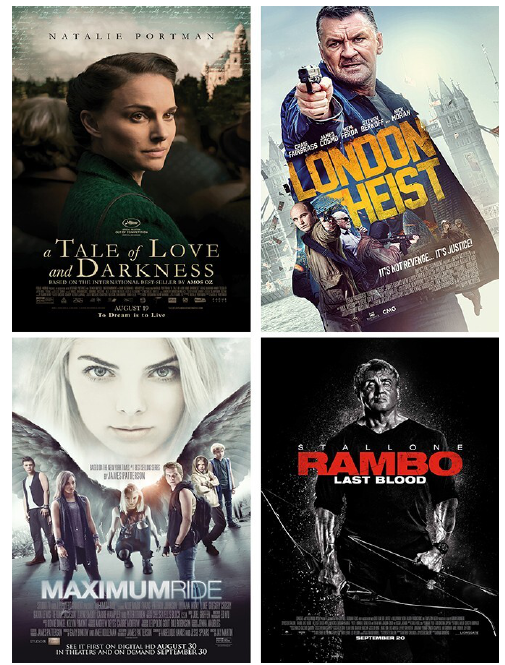
Figure 2. Sample of movie poster in the our dataset.